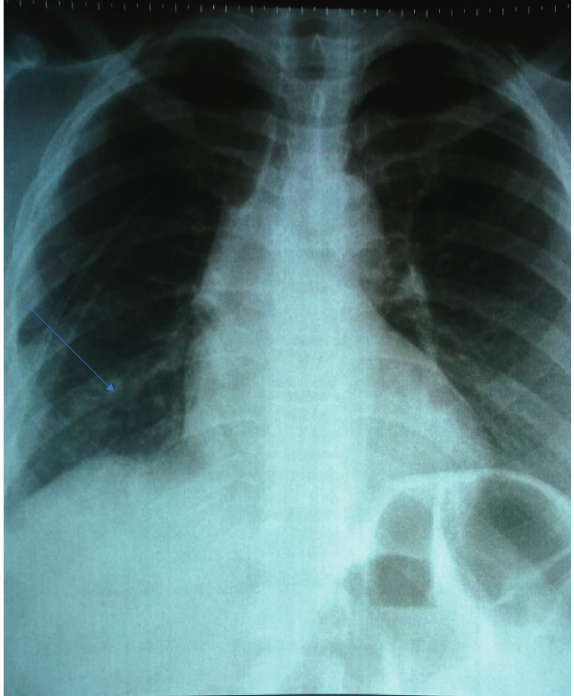
Figure 2: A plain chest radiograph of the study subject in ante- rioposterior view showing a near total re-expansion of the lung after chest tube